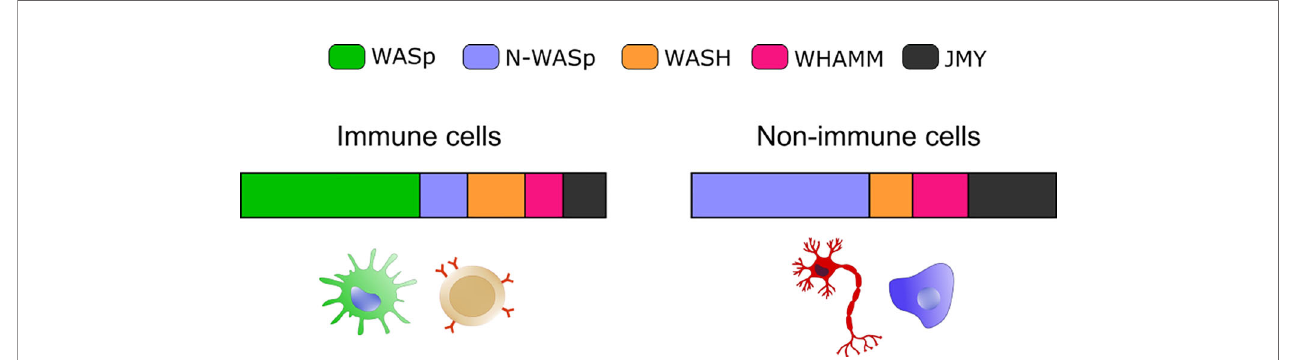
FIGURE 1 | Expression of selected NPFs in immune and non-immune cells. Bar graphs show the relative abundance of the indicated NPF. The “ immune cells ” plot integrates values from: B cells (bone marrow), Macrophage (bone marrow and spleen) and Classical Monocyte (lung). The “ non-immune cells ” includes: Epithelial Cell (lung), Fibroblastic Cell (heart), Neuron (brain), Hepatocyte (liver) and Endothelial cell (mammary gland). Plots were obtained by merging expression from different cell types and plotting the resulting average value. Data are from the Tabula Muris website (https://tabula-muris.ds.czbiohub.org/) FACS sorted single cell types RNA-seq.